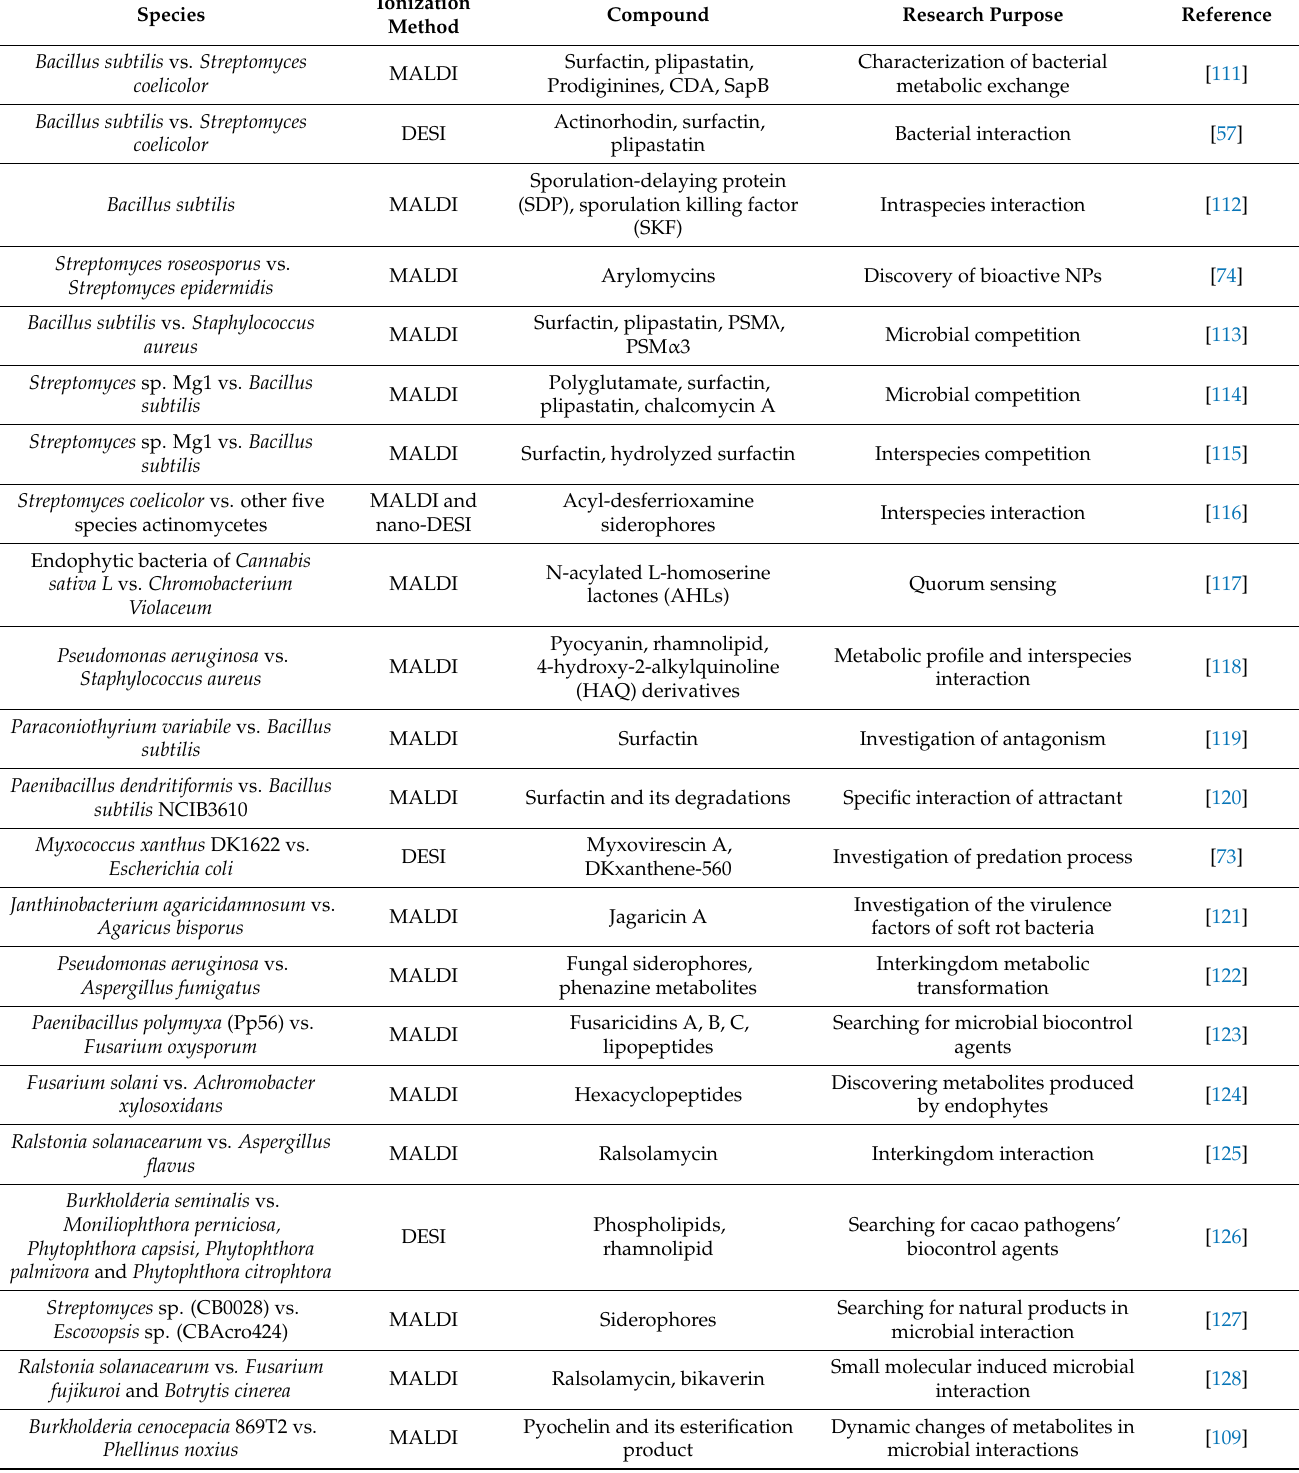
Table 5. MSI application in the research of microbial binary